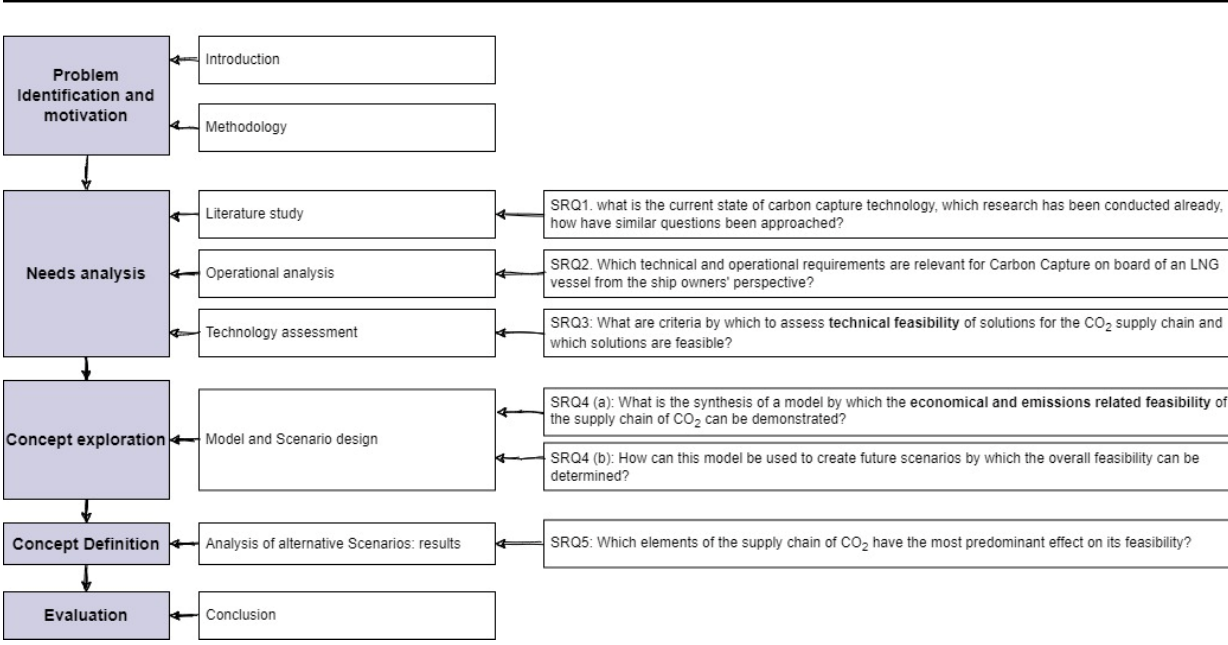
Figure 1. Research methodology incl. structure of the paper and sub research questions, adopted from [17].